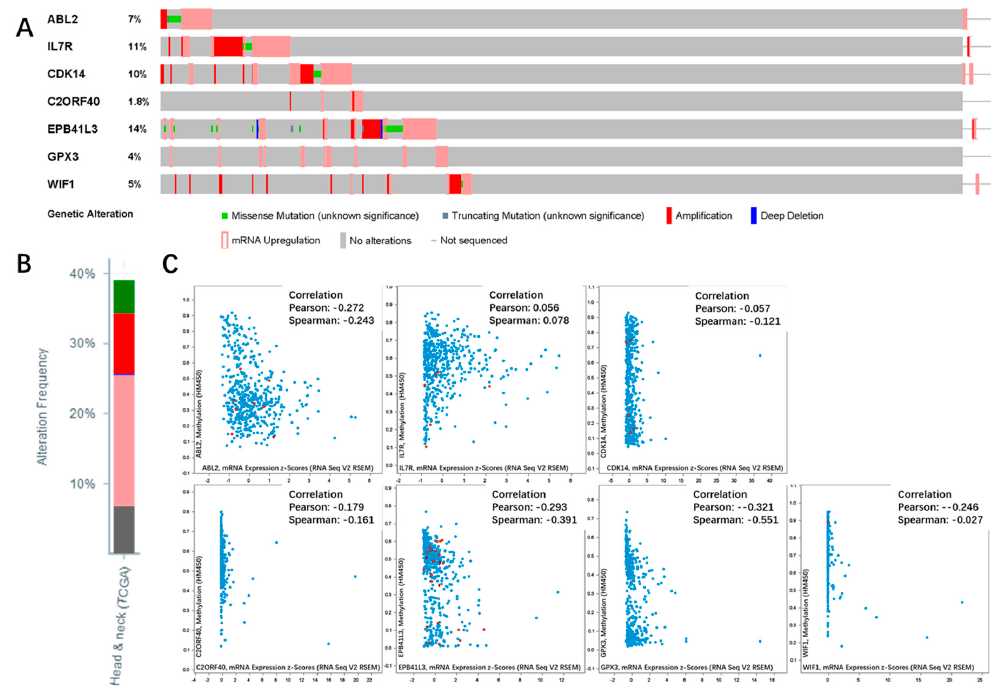
Figure 8. Genetic alterations connected with the seven genes, and the correlation between mRNA and DNA methylation in the TCGA HNSC study. ( A ) A visual summary across a set of HNSC (data from head and neck squamous cell carcinoma TCGA, provisional) shows the genetic alteration of the seven genes which were altered in 207 (41%) of the 510 sequenced cases/patients (528 total). ( B ) An overview of changes in the seven genes in the genomics datasets of TCGA. ( C ) Correlation between mRNA and DNA methylation in the seven genes in TCGA HNSC patients.